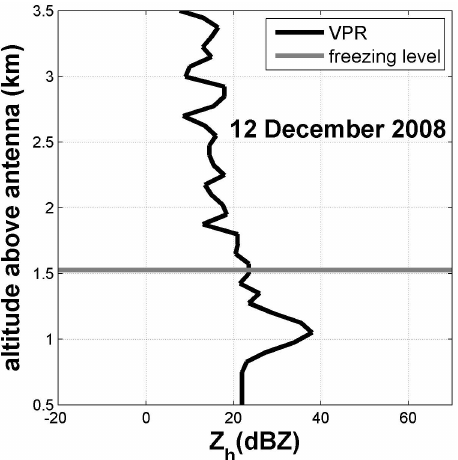
Fig. 8. Reflectivity as a function of altitude (km) and 0 ◦ C isother- mal height at 03:10 a.m., both relative to the stratiform event of 12 December